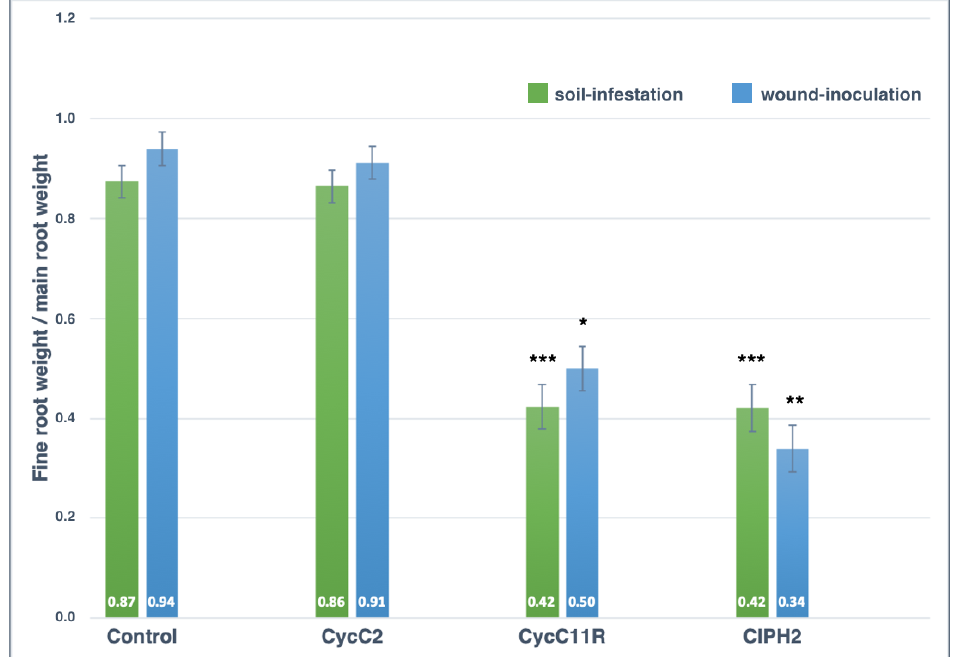
Figure 8. The mean fine root weight/main root weight ratio of Cycas revoluta plants 2 months after transplanting in the soil-infestation and wound-inoculation tests with non-infested soil/non-inoculated control (control), P. multivora (CycC2), P. nicotianae (CycC11R) and P. pseudocryptogea (CIPH2). Bars show standard deviations; asterisks represent statistical significances (*** = p < 0.001; ** = p < 0.01; * = p < 0.05).